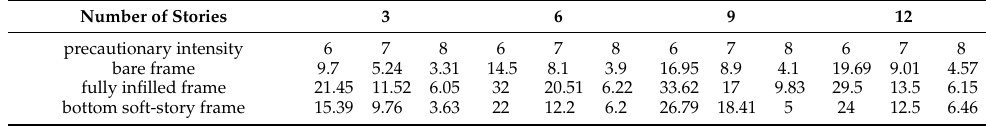
Table 4. Over-strength coefficient values of 36 RC frame structures.